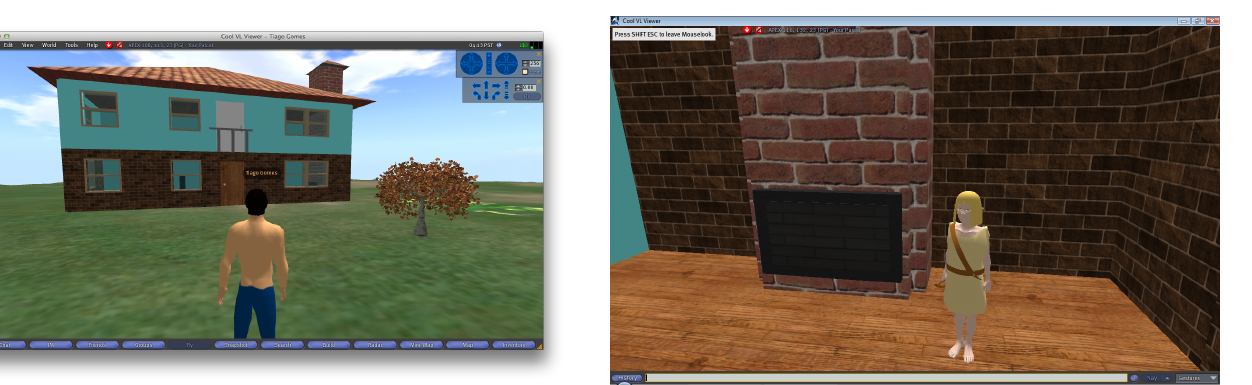
Figure 3. A fire place in the